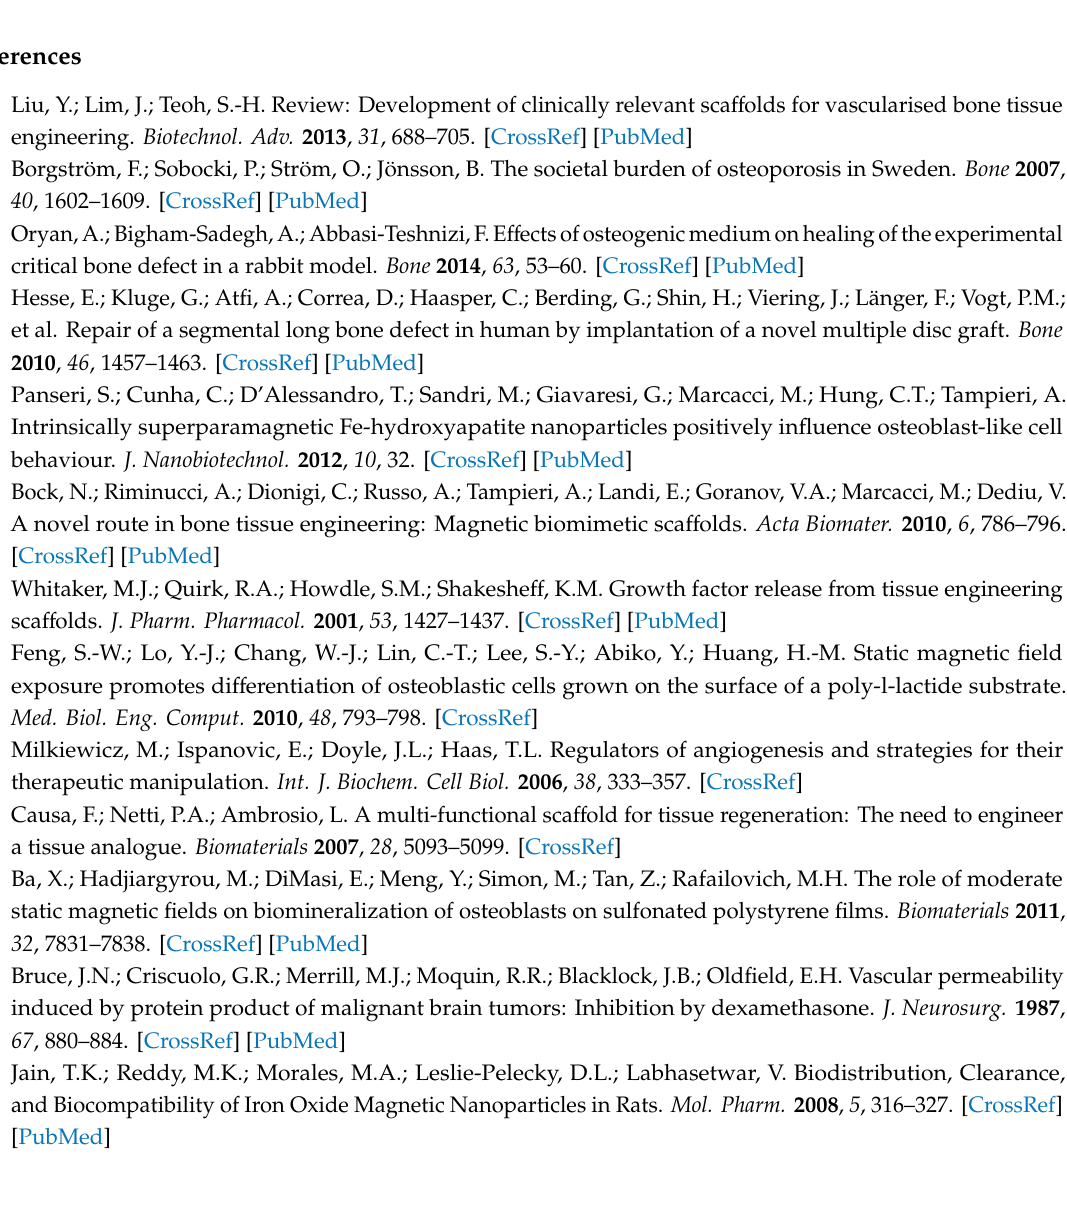
SMF of 1.3 T. Figure S3: SEM micrographs illustrating cells attached on sca ff olds with MNPs concentrations of: (a) 0 mg / mL; (b) 2 mg / mL; (c) 4 mg / mL, after 3 days of cultivation, in the absence (upper panel) and in the presence (lower panel) of SMF. The cells are indicated by red arrows. Figure S4: Preliminary results in vivo: CT scans of Wistar rats with sca ff olds implanted at femoral level, at di ff erent time points after the implantation